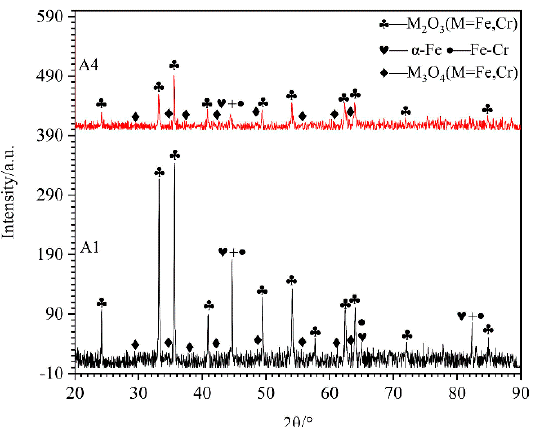
Figure 10. XRD patterns of A1 and A4 samples after oxidation wear at 800 °C for 100 N.